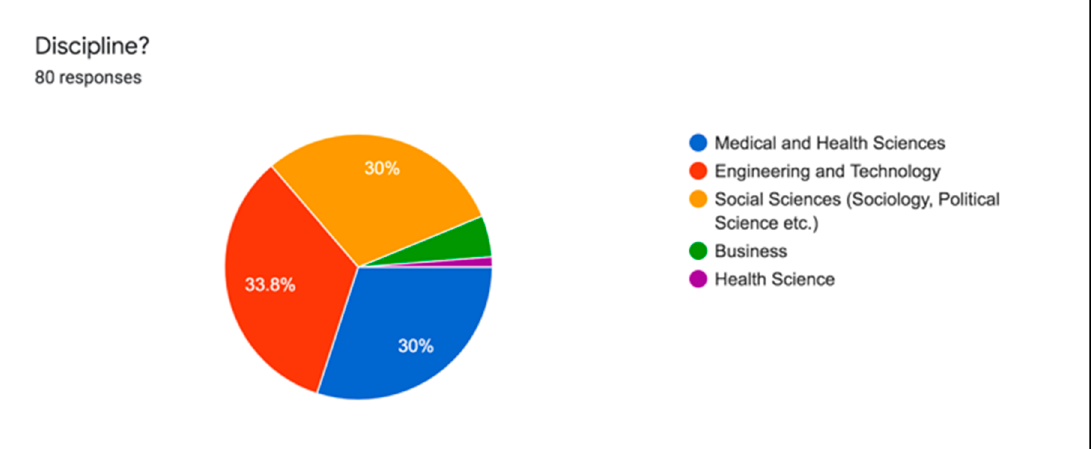
Figure 4. Disciplines of the paper reviews.